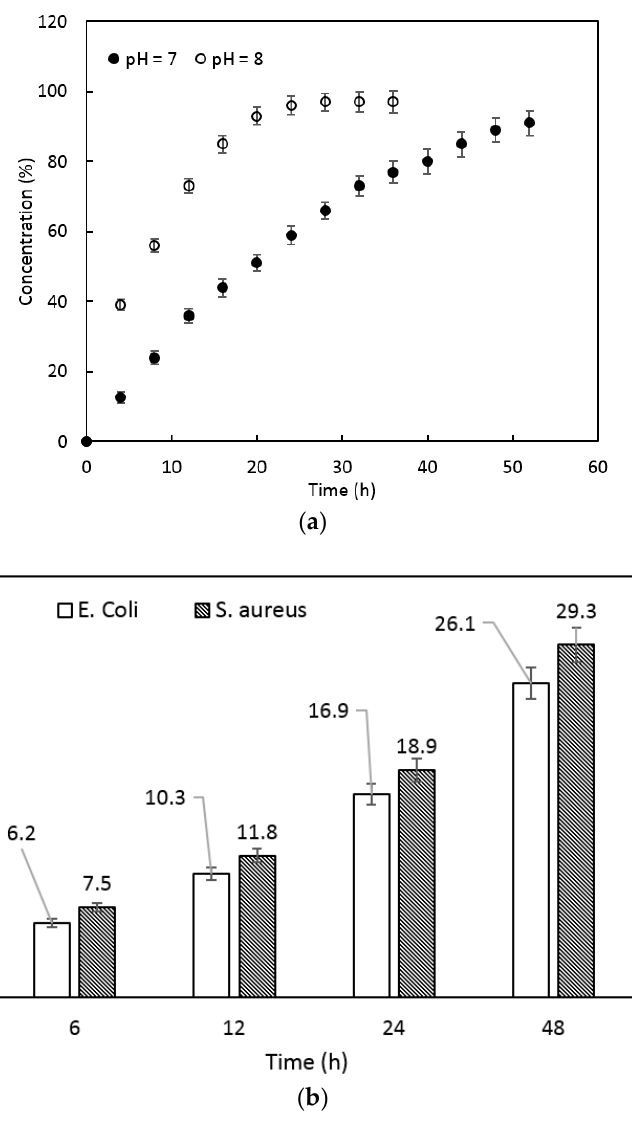
Figure 8. ( a ) Tetracycline release from PVA-PAA samples at different pH values and ( b ) Changes in the diameter of the inhibition zone at different time points.